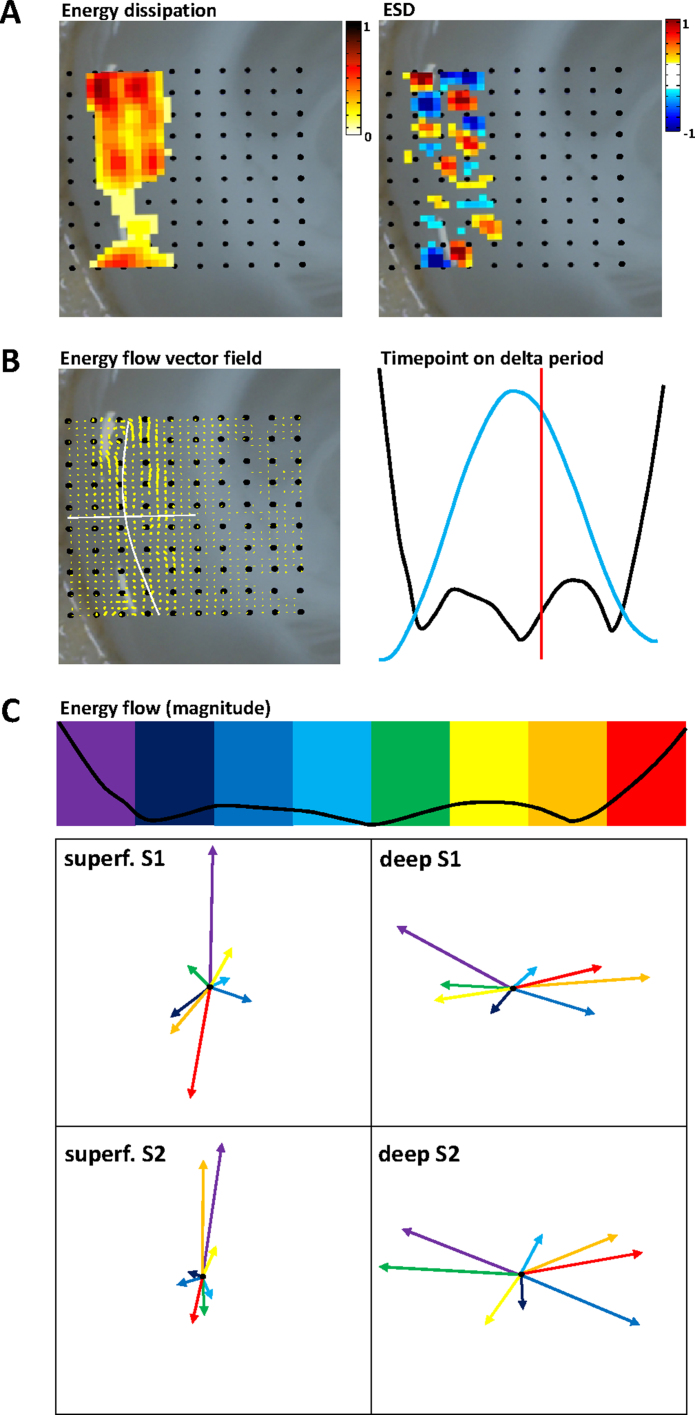
NEH reveals lamina-specific structure of spatial interactions nested within each period of the delta rhythm. (A) Estimation of the combined electromagnetic behaviour of neural activity from multiple periods (n = 60) allows the separation of the reconstructed signal into that which is ‘lost’ in terms of local activity in the system (energy dissipation, upper left panel) and that which is propagated within the tissue (energy source density, upper right panel). Note, energy dissipation reflects the predominantly infra- and supragranular laminar structure of the delta rhythm (e.g. Carracedo et al., 2013) whereas source density (ESD) reveals a ‘chequerboard’ spatial structure in which regions propagate activity to their near neighbours both horizontally and radially in neocortex. Note the colorbar scales for dissipation and ESD have arbitrary units. (B) These local interactions, derived from the vector field (upper left panel) can be studied at discrete timepoints by plotting the magnitude (black line, upper right panel) against the original, low pass filtered average delta period (blue line). Note the timepoint indicated by the red cursor corresponds to the vector field shown in the left panel. (C) Poynting vectors averaged in 4 regions (deep and superficial primary (S1) and secondary (S2) somatosensory cortices (see (B) left panel for regional separation)) at 8 timepoints within an average delta period. The combined electromagnetic nature of the tissue-generated activity revealed a dichotomy between supra and infragranular layer interactions: During delta rhythms infragranular layers projected their energy predominantly interlaminarly whereas supragranular layers projected horizontally. In both cases at least two cycles of vector change were seen nested within each average delta period.